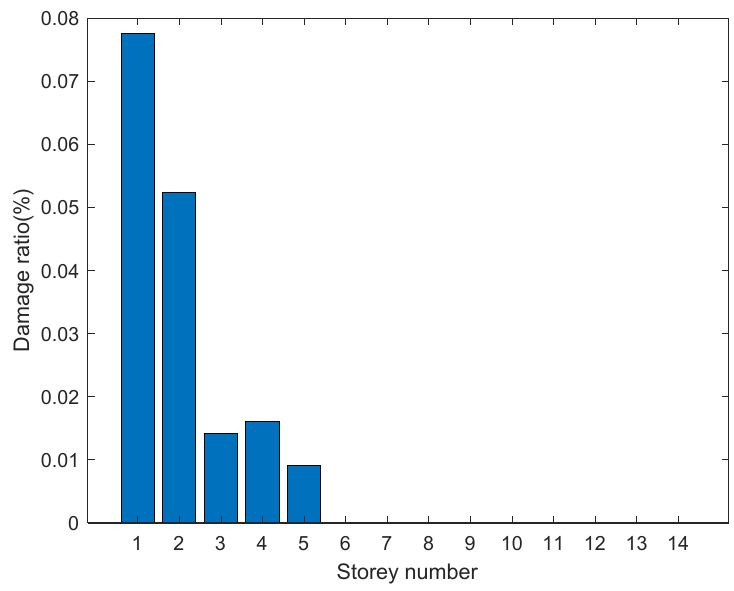
Figure 13. Identified damage ratio of the shear frame.